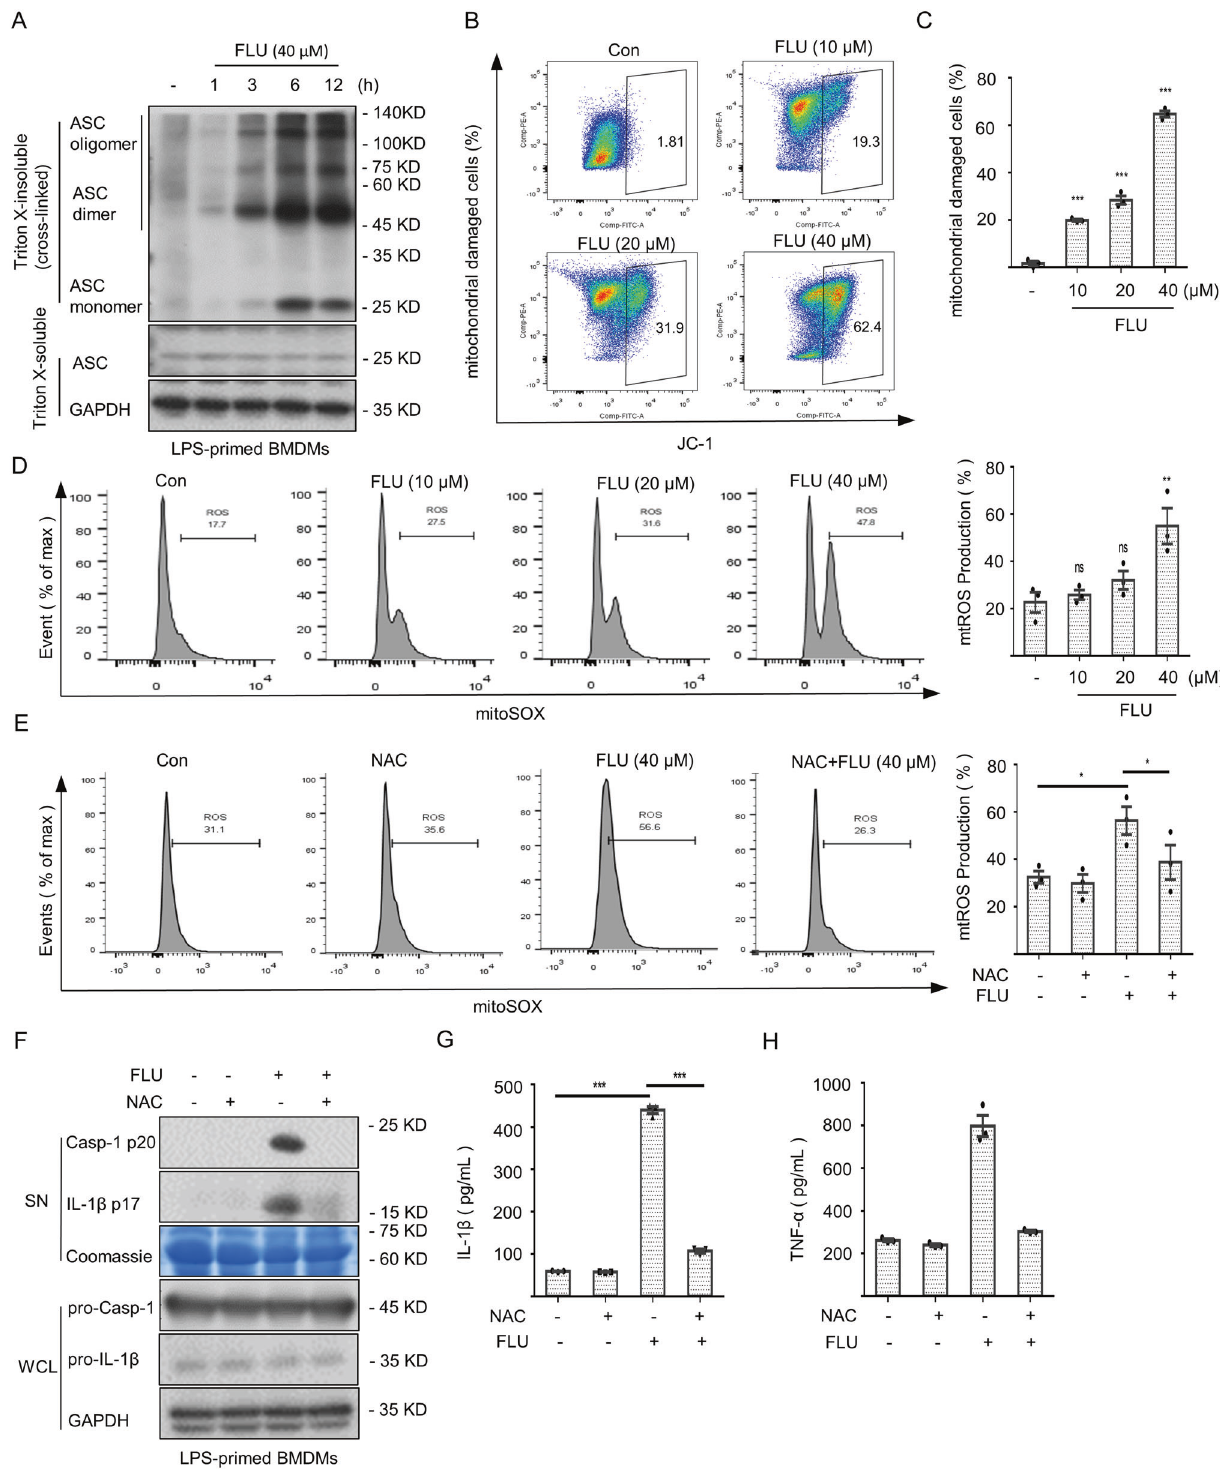
Fig. 4 Mitochondrial damage and mtROS accumulation are crucial molecular signals for fl uoxetine-induced NLRP3 in fl ammasome activation. A The oligomerization of ASC after DSS crosslinking in WCL was measured by western blotting. B , C The mitochondrial damage was assessed using a JC-1 mitochondrial membrane potential assay kit. D LPS-primed BMDMs were stimulated with fl uoxetine for 6 h and the mtROS content was measured by fl ow cytometry. E – H LPS-primed BMDMs were pretreated with NAC and then treated with fl uoxetine (40 μ M) for 6 h, the mtROS content ( E ) was measured by fl ow cytometry. The expression levels of cleaved caspase-1 and IL-1 β in SN ( F ) were detected by western blotting and using ELISA kits to detect the secretion of IL-1 β ( G ) and generation of TNF- α ( H ) in SN. Data are shown as the mean ± SEM from three biological samples; *P < 0.05, **P < 0.01, ***P < 0.001, ns, not signi fi cant. One-Way ANOVA analysis followed by Dunnett ’ s post hoc test.